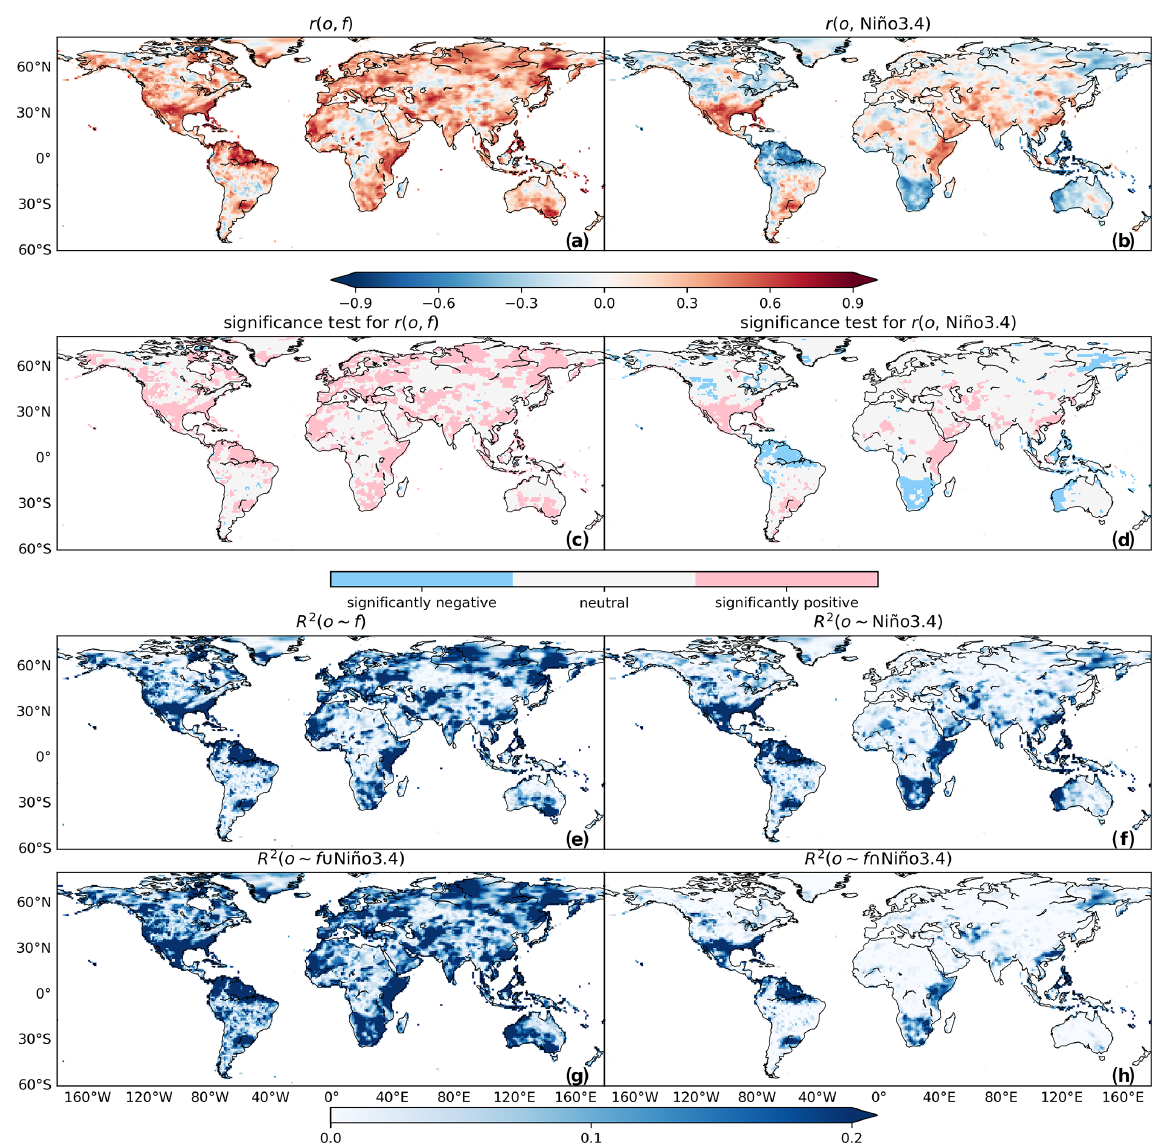
Figure 4. Correlation coefficients between observed precipitation in DJF with (a) 0-month lead CFSv2 forecasts generated at the beginning of December and (b) concurrent Niño3.4. Significance tests of correlation for (c) CFSv2 forecasts and (d) Niño3.4. Coefficient of determina- tion ( R 2 ) for the regression of observed precipitation against (e) CFSv2 forecasts, (f) Niño3.4, (g) the union of CFSv2 forecasts and Niño3.4 and (h) the intersection of CFSv2 forecasts and